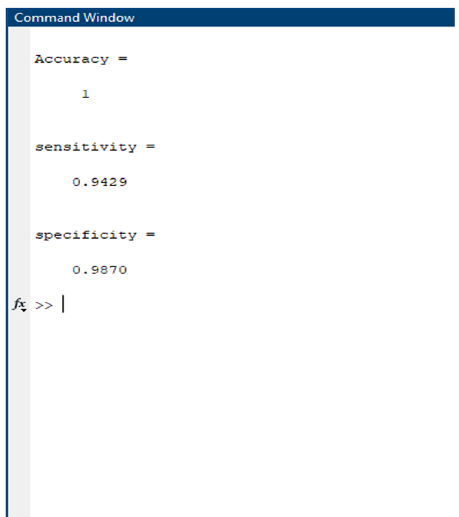
Figure 7: Attribute selection evaluation.